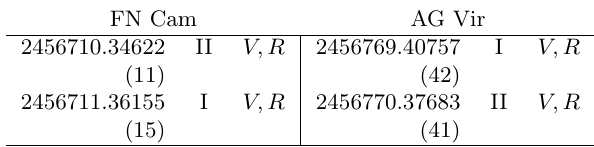
Table 2. Minima times for FN Cam and AG